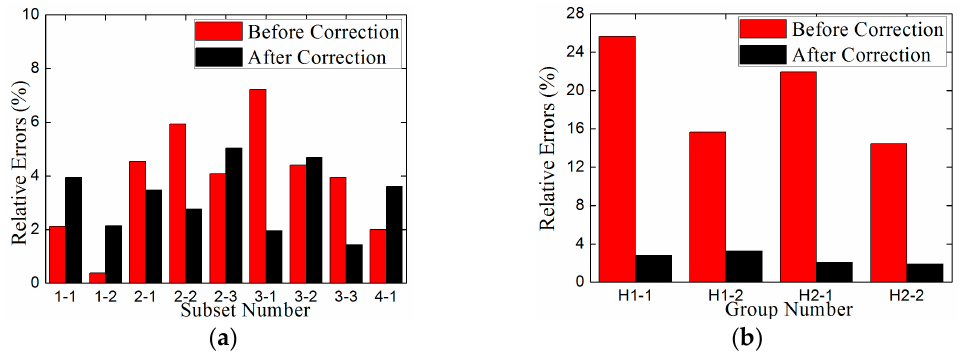
Figure 20. ( a ) The relative measuring errors for step force before and after correction; ( b ) The relative measuring errors for harmonic force before and after correction.